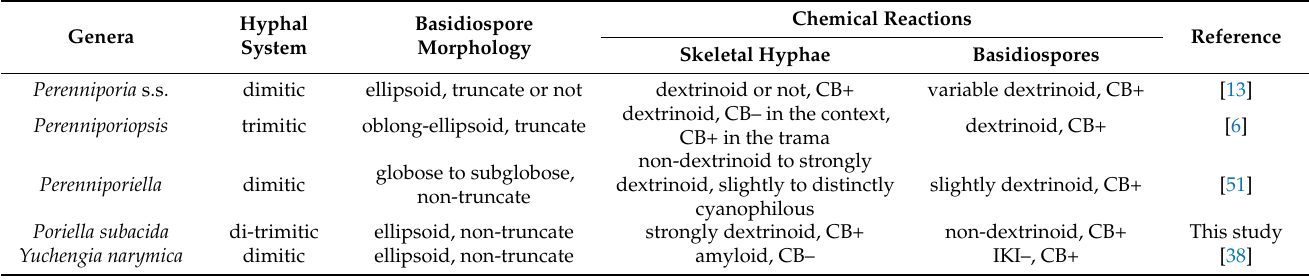
Table 2. A comparison of Poriella subacida and related genera and